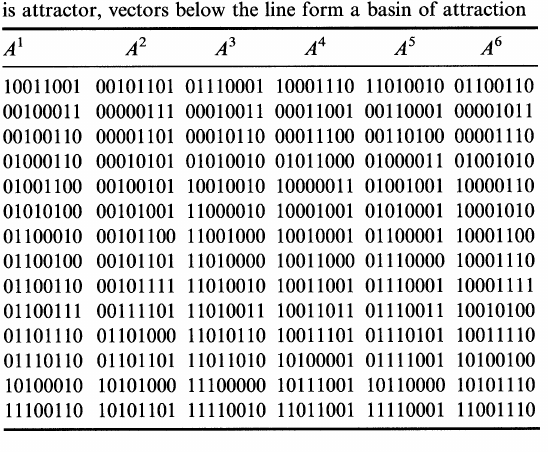
The classification table of the network with the synaptic matrix Eq. (7). In each column, vector beyond the line is attractor, vectors below the line form a basin of